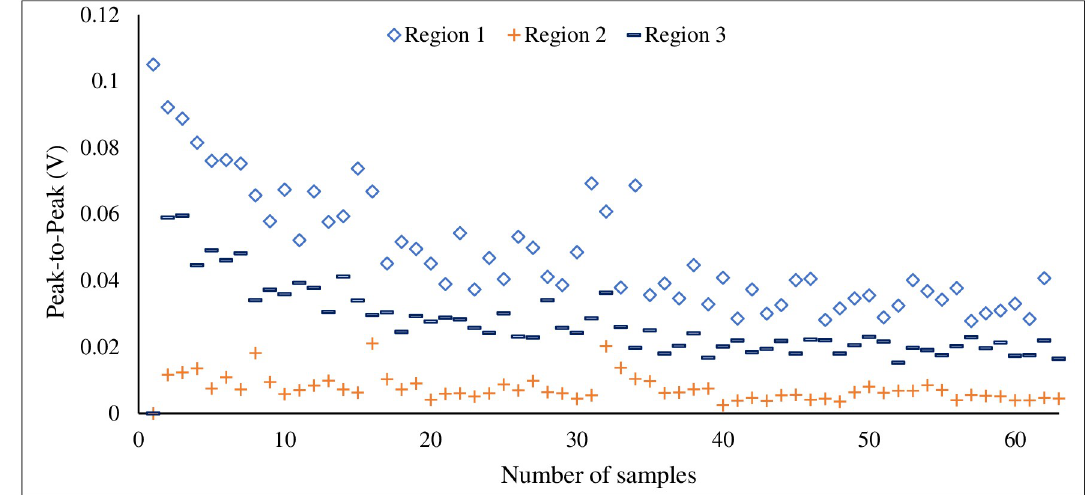
Fig 15. Peak-to-Peak (V), time-domain features for three stages of